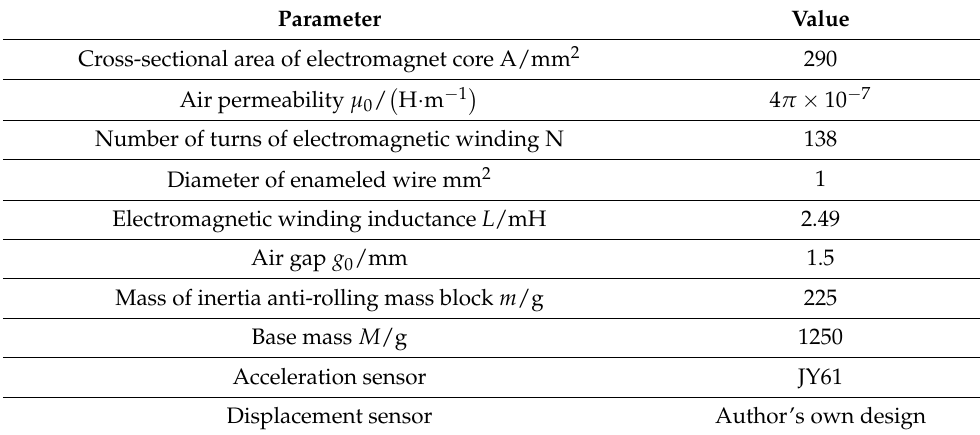
Table 1. Parameters of EMS inertial